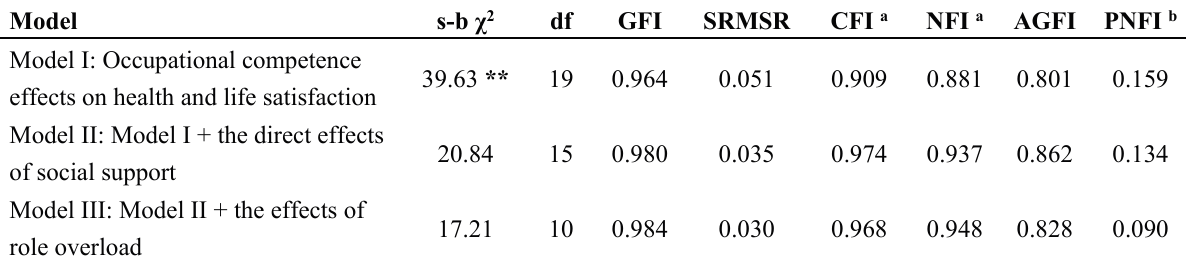
Table 4. The goodness of fit of the three alternative nested models (N =